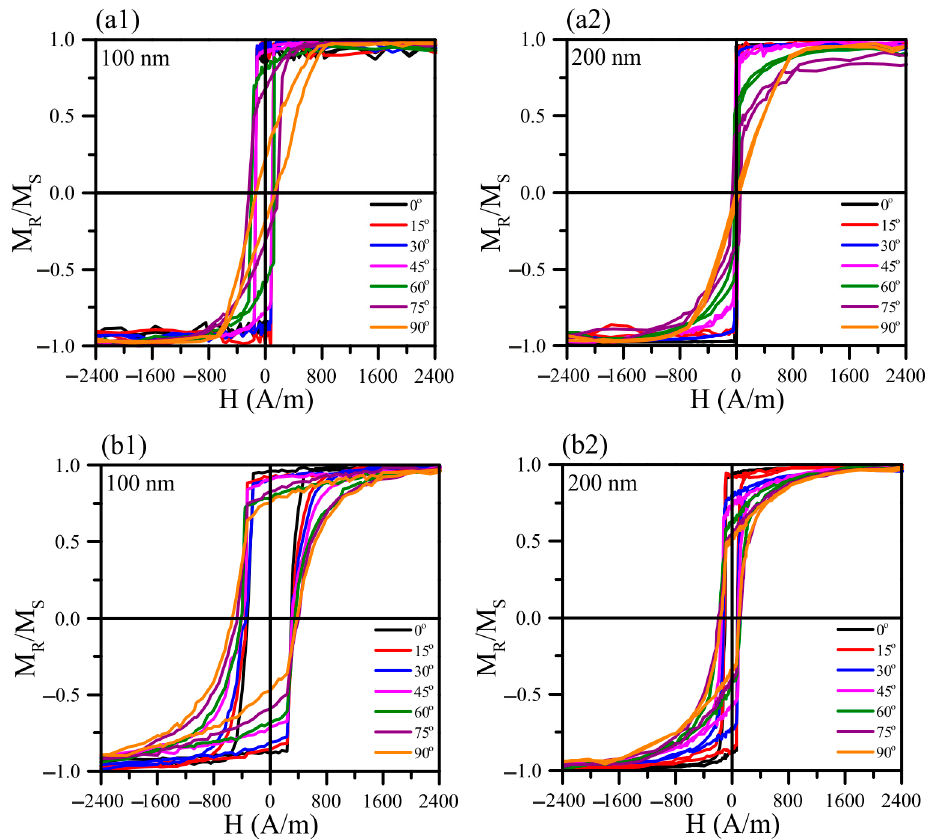
Figure 6. Hysteresis loops of the of Fe 73.5 Nb 3 Cu 1 Si 13.5 B 9 ( a1 , a2 ) and Fe 72.5 Nb 1.5 Mo 2 Cu 1.1 Si 14.2 B 8.7 ( b1 , b2 ) films with thicknesses of 100 and 200 nm in the as-prepared state measured under different angles with respect to the direction of the magnetic field applied during deposition: zero angle coincides with the direction of the easy magnetization axis (EMA).